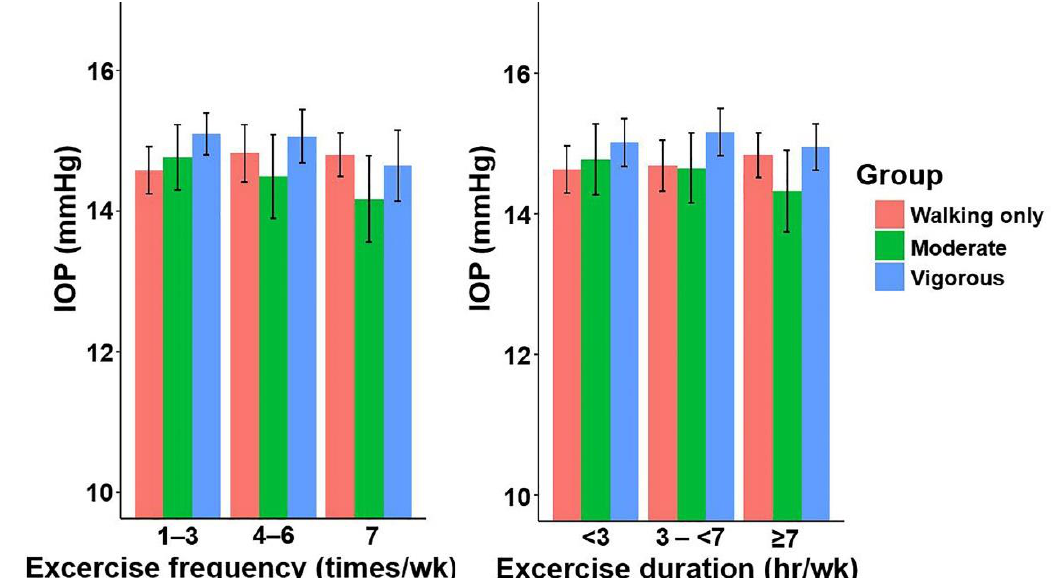
Figure 3. Mean IOPmax according to the frequency and duration of physical activity in men aged ≥40 years. Linear regression model after adjusting for age, body mass index, smoking, drinking, monthly income, total energy intake, caffeine intake and diabetes mellitus, hypertension and spherical equivalents. Error bars indicate 95% confidence intervals. IOPmax, the highest intraocular pressure of both eyes.